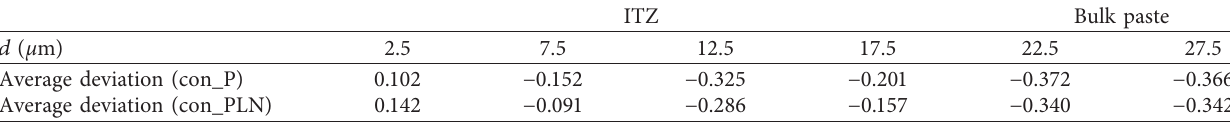
Table 6: Deviation of upper limit of ITZ Young’s